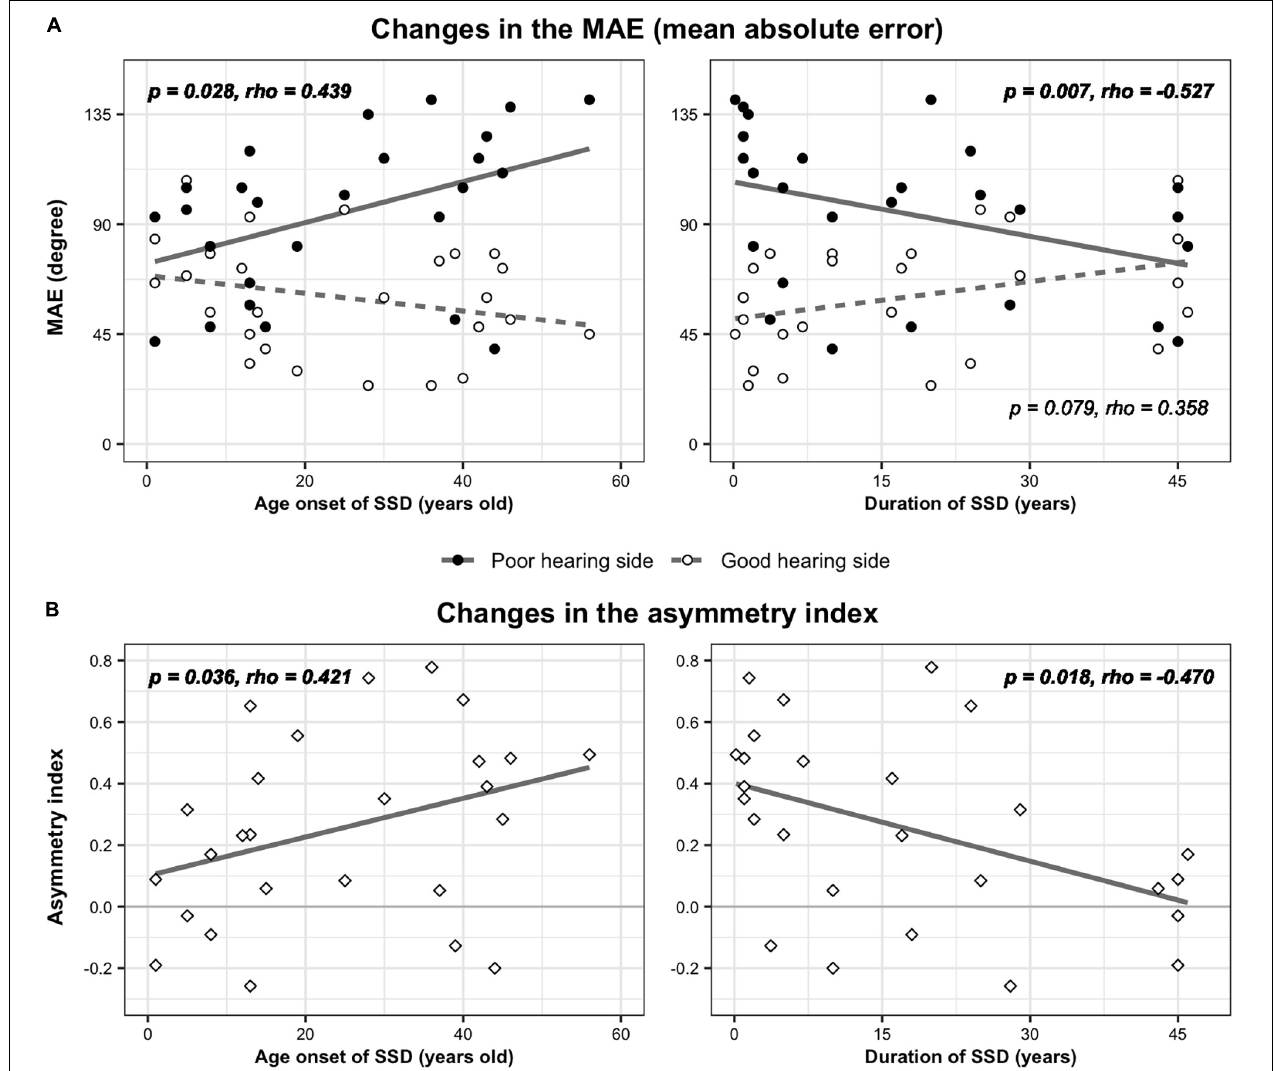
FIGURE 4 | Changes in localization parameters with age of SSD onset and SSD duration. (A) MAE values of three speakers on the good- and poor-hearing sides were plotted as a function of onset age (left) and duration (right) of SSD. (B) The asymmetry index, which represents the relative difference in weighted MAE values between the good- and poor-hearing sides, was also plotted by the onset age (left) and duration (right) of